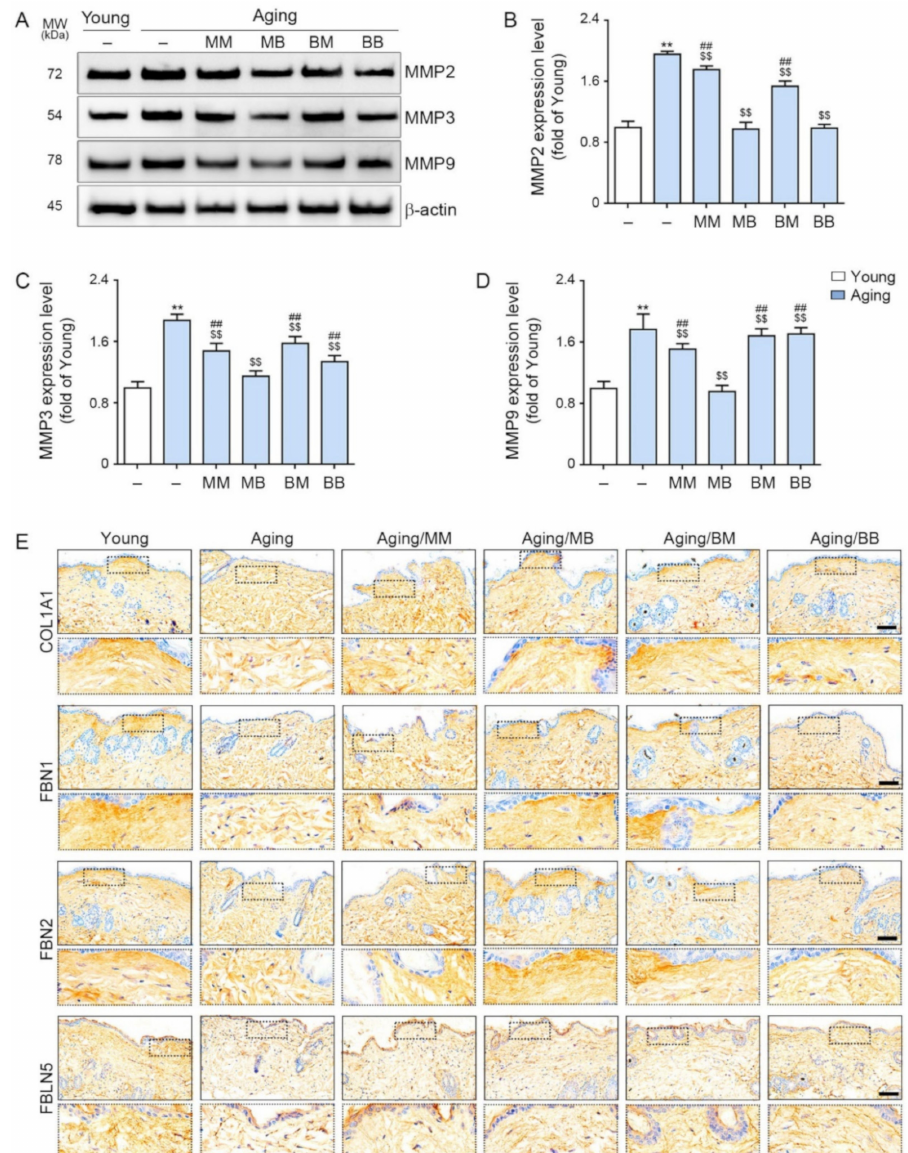
Figure 4. The modulating effect of MMP2/3/9, COL1A1, FBN1/2, and FBLN5 depending on the combinations of RF modes: ( A ) The expression levels of MMP2, 3, and 9 in the skin protein were assessed by Western blot. ( B – D ) Quantitative graphs and representative Western blot images. ( E ) COL1A1, FBN1/2, and FBLN5 expression in the dermis of the skin from the aged mice was assessed immunohistochemically (scale bar = 100 µ m). Data are presented as mean ± SD. **, p < 0.01, vs. Young; $$, p < 0.01, vs. Aging; ##, p < 0.01, vs. Aging/MB (Mann–Whitney U test). MM, monopolar mode applied twice; MB, application of the monopolar mode followed by the bipolar mode; BB, bipolar mode applied twice; BM, application of bipolar followed by monopolar mode; MMP, metalloproteinases; COL1A1, collagen type I α 1; FBN, fibrillin; FBLN,